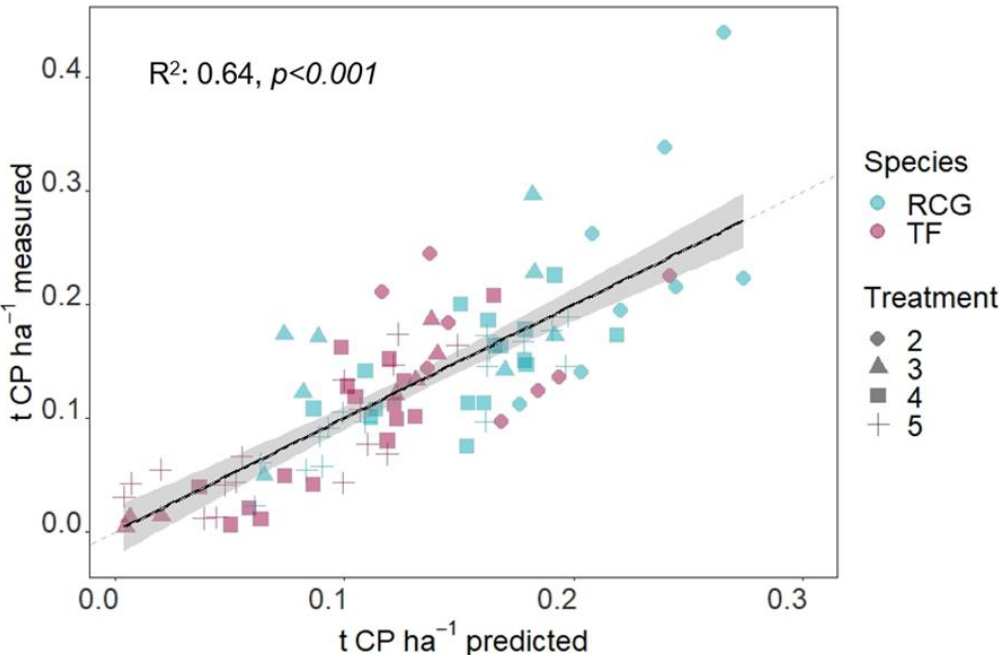
Figure 3. Regression plot of measured vs. model derived (predicted) yields of crude protein (CP) in protein precipitate (t ha -1 ) across treatments of harvest frequencies (2 to 5 harvest occurrences per year) and the two species Phalaris arundinacea (RCG) and Festuca arundinacea